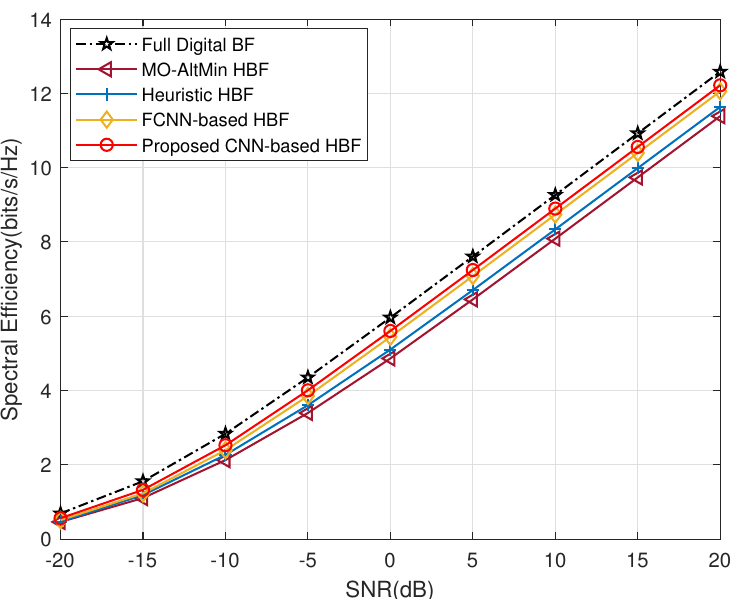
Figure 11. Comparison of spectral efficiency performance among different schemes about specific solution for an individual CSI in Rayleigh fading channel with N t = 64.